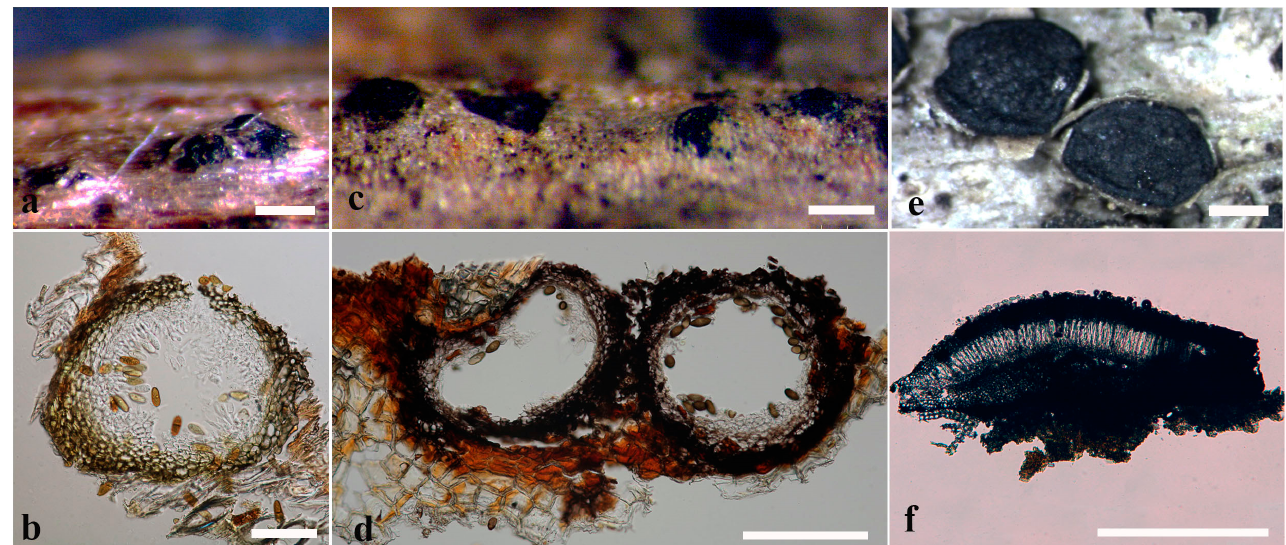
Figure 1. Uni-loculate and multi-loculate ascostromata/conidiomata. ( a , b ) Uni-loculate conidiomata of Dothiorella viticola . ( c , d ) Uni-loculate ascostromata of Sphaeropsis sp. ( e , f ) Multi-loculate ascostromata of Aplosporella thailandica [36]. Scale bars: ( a , c , d ) = 200 μ m, b = 100 μ m, ( e , f ) = 500 μ m.